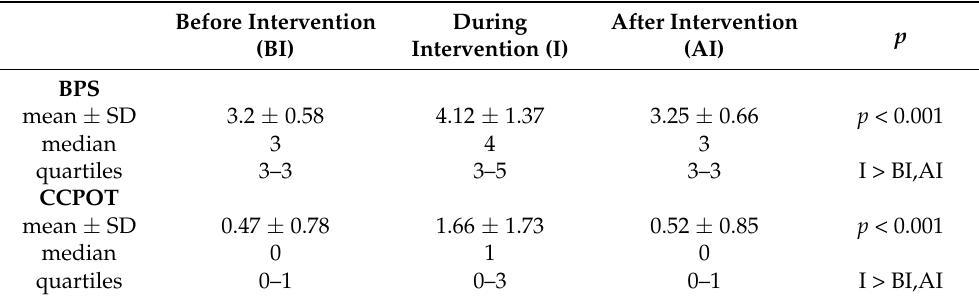
Table 4. Correlations between RASS scores and BPS, CCPOT scores. Parameter BPS before